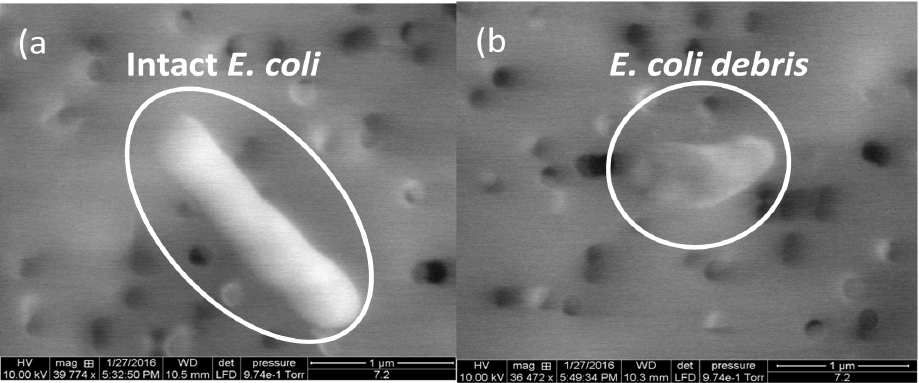
Figure 3. An example of SEM images of E. coli cells ( a ) before and ( b ) after electrocatalytic reactor treatments. Physical damage and E. coli death in the ER occur due to cell reactions with radical species generated at the surface of TiO 2 . When an anodic bias is applied to the TiO 2 -based electrode, valence band (VB) electrons are excited to the conduction band, creating “holes” within the VB (h VB+ ). If in an aqueous solution, these holes react with adsorbed water and/or hydroxyl ions for the direct production of hydroxyl radical (OH • ) at the surface of the TiO 2 , as shown in Equation (1)